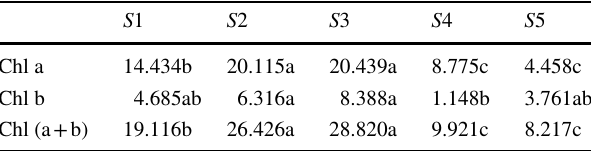
Table 3 The effect of different substrates on chlorophyll content